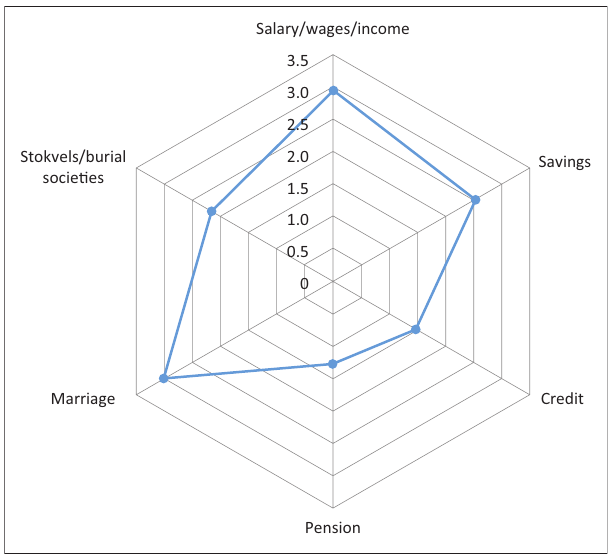
FIGURE 2: Economic factors of survival. TABLE 6: Ratings for physical livelihood capital factors ( n = 332). Physical livelihood capital factor